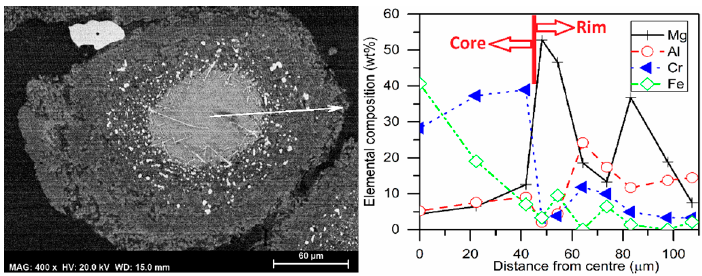
Figure 13. Cross section of a partially reduced chromite particle (180–300 µm) showing the residual chromite core ( left ); and the EDS elemental scan along the white arrow ( right ).